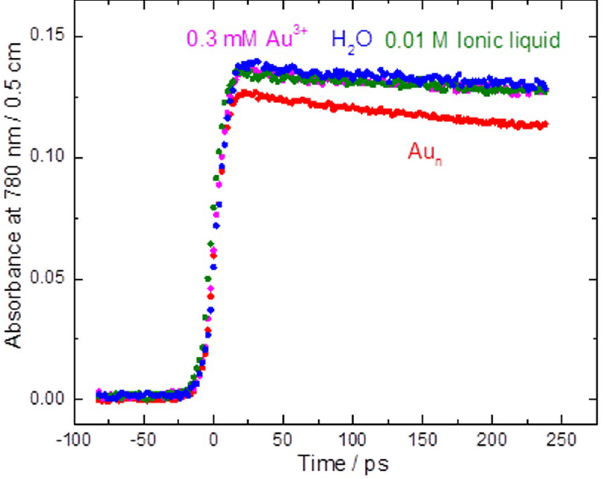
Figure 2. Recorded kinetics at 780 nm in water up to 250 ps for a solution of ionic liquid in water at the same concentration used to stabilize gold nanoparticles, solution of 3.3 × 10 − 8 M naked 15 nm gold nanoparticles in water (Au n ), and solution of 0.3 mM Au 3 + in water (Au 3 + was used as precursor of gold nanoparticles) at 23 °C.